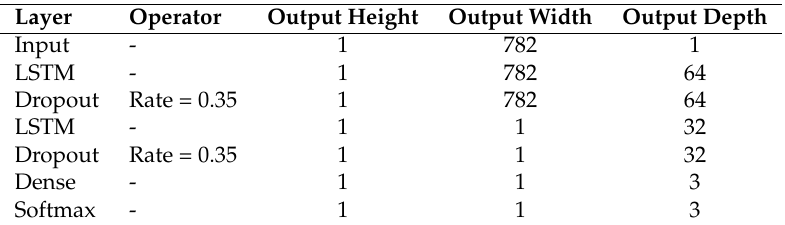
Table 3. Dimension and Operations of